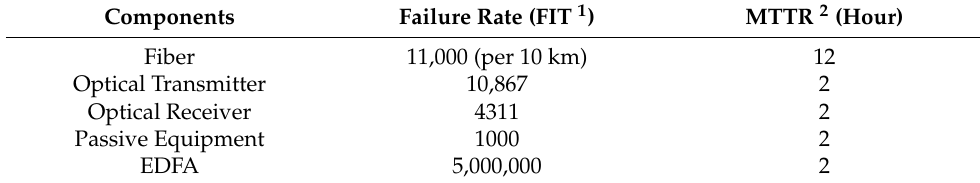
Table 1. Failure rates and repair times [10,11]. Components Failure Rate (FIT 1 ) MTTR 2 (Hour) Fiber 11,000 (per 10 km) 12 Optical Transmitter 10,867 2 Optical Receiver 4311 2 Passive Equipment 1000 2 EDFA